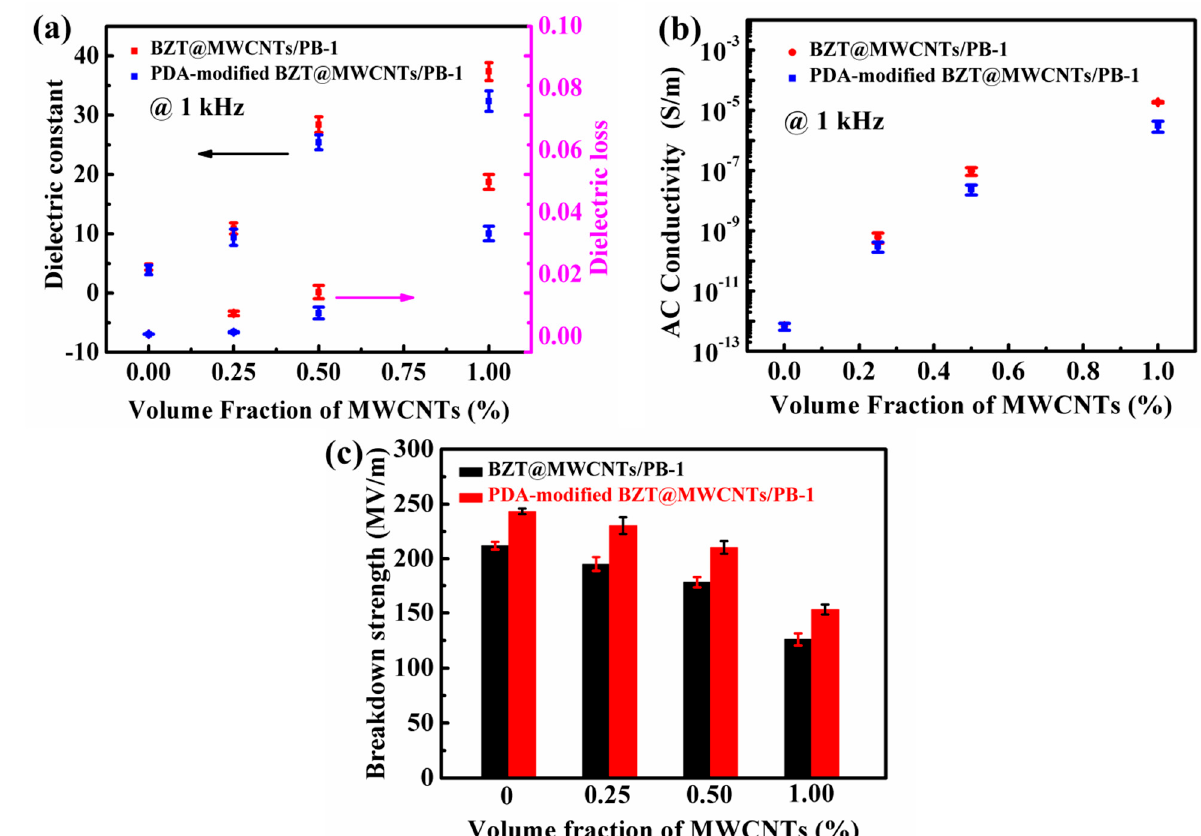
Figure 8. Effects of PDA modification on ( a ) the dielectric constant and dielectric loss, ( b ) AC conductivity, and ( c ) break- down characteristics of the BZT@MWCNTs/PB-1 composite films with different MWCNTs contents.